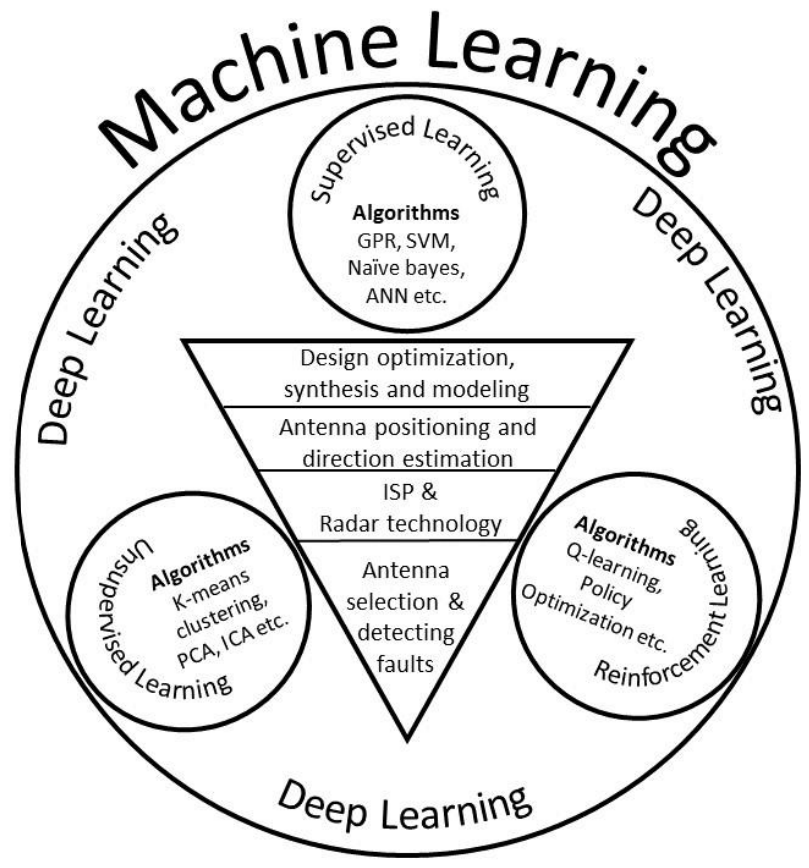
Figure 8. Applications of Machine Learning in the field of electromagnetics.